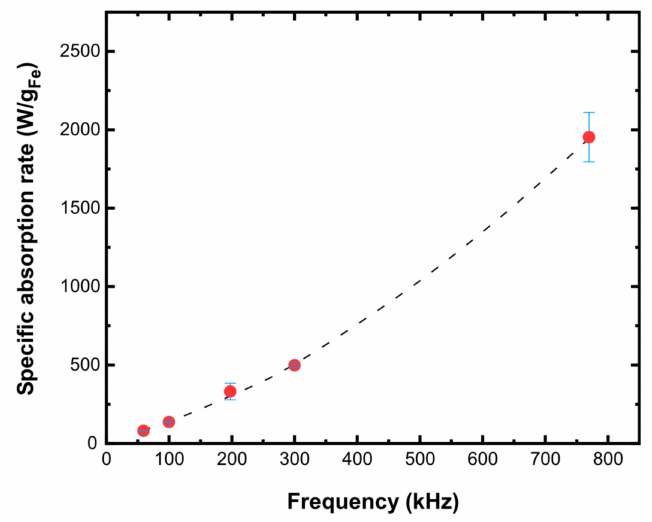
Figure 6. SAR values determined at various AC magnetic field frequencies and strength 24 kA/m for aqueous dispersions (2 g/L) of MGT-35. Dashed line is a guide to the